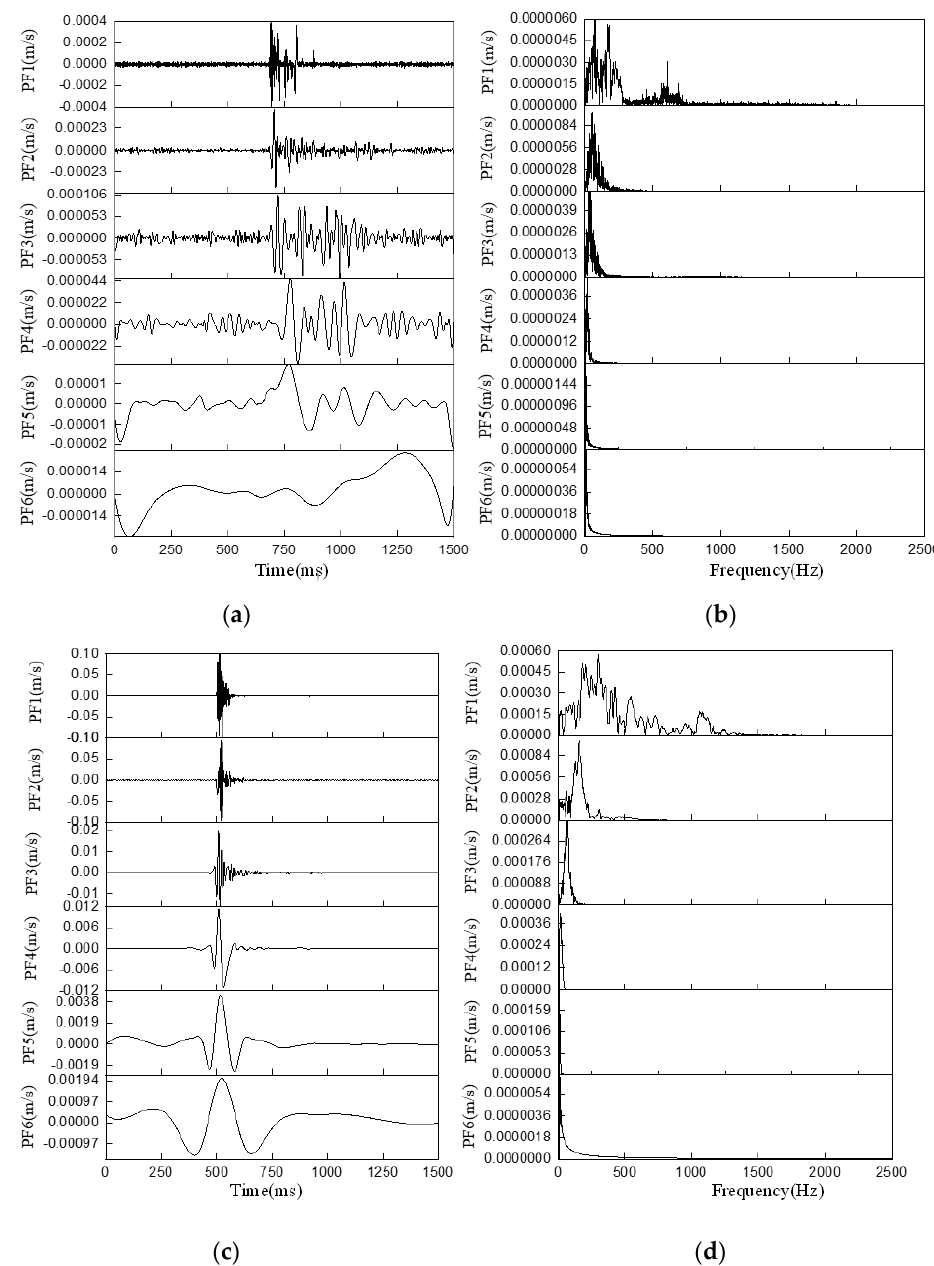
Figure 7. LMD decomposition and frequency spectrum of typical microseismic signals in mines. ( a ) PF component of coal-and-rock-mass-fracture signal; ( b ) PF component frequency spectrum of coal-and-rock-mass-fracture signal; ( c ) PF component of blasting-vibration signal; ( d ) PF component frequency spectrum of blasting − vibration signal.